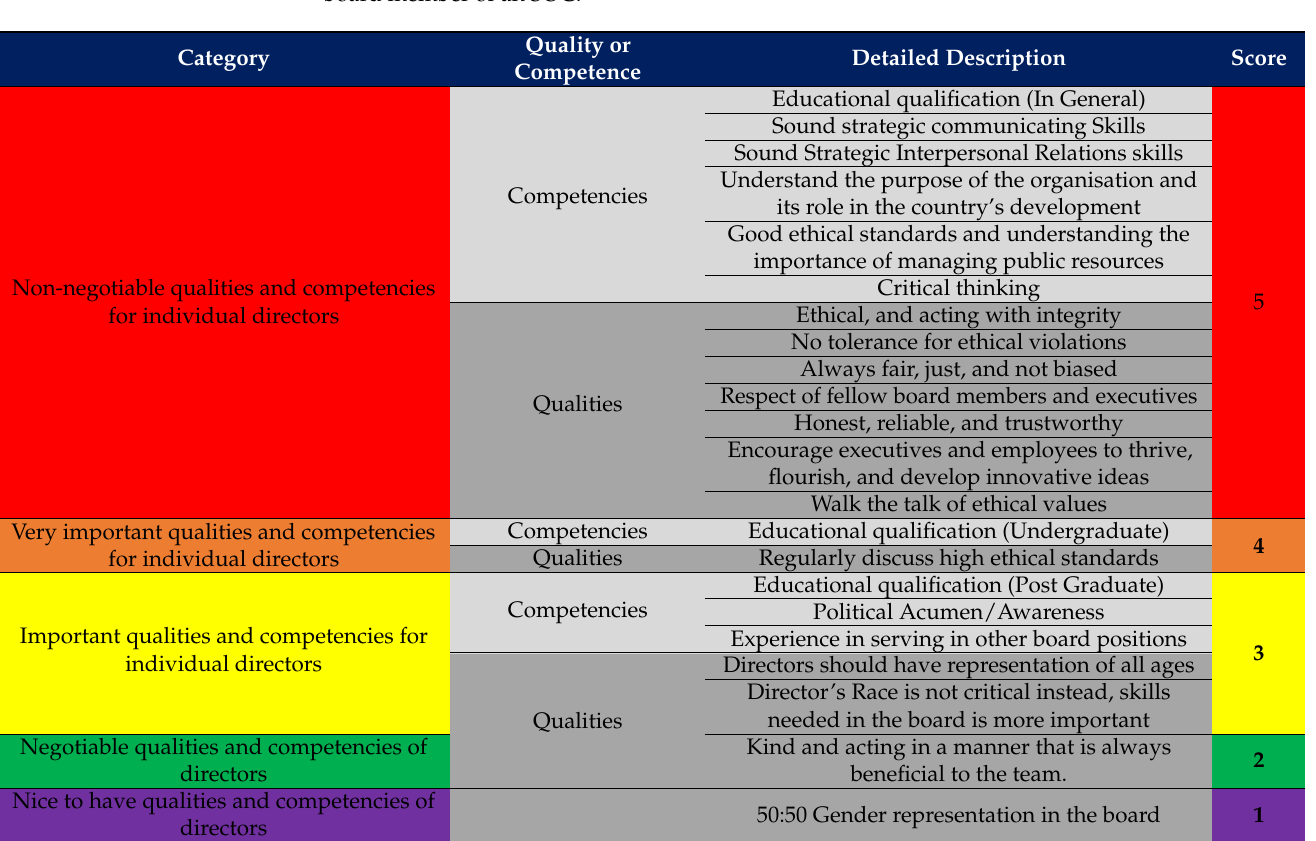
Table 2. Proposed framework of competencies and qualities for screening the potential individual board member of an